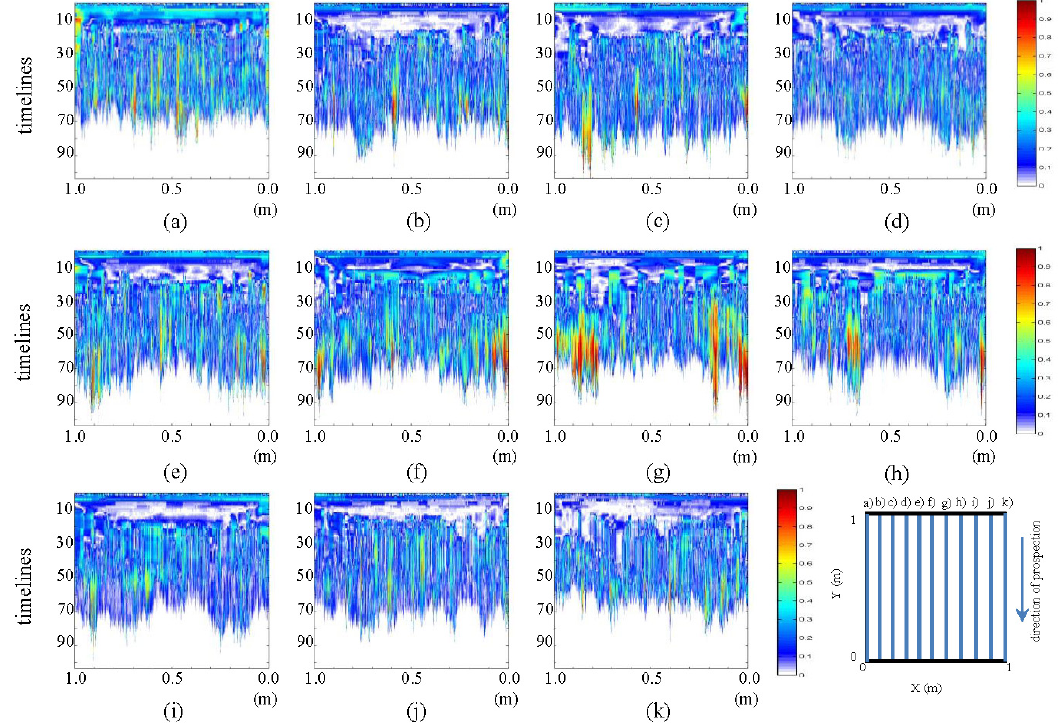
Figure 18. Vertical profiles: contrast between pre-processed images. ( a – k ) are profiles s12 to s22,